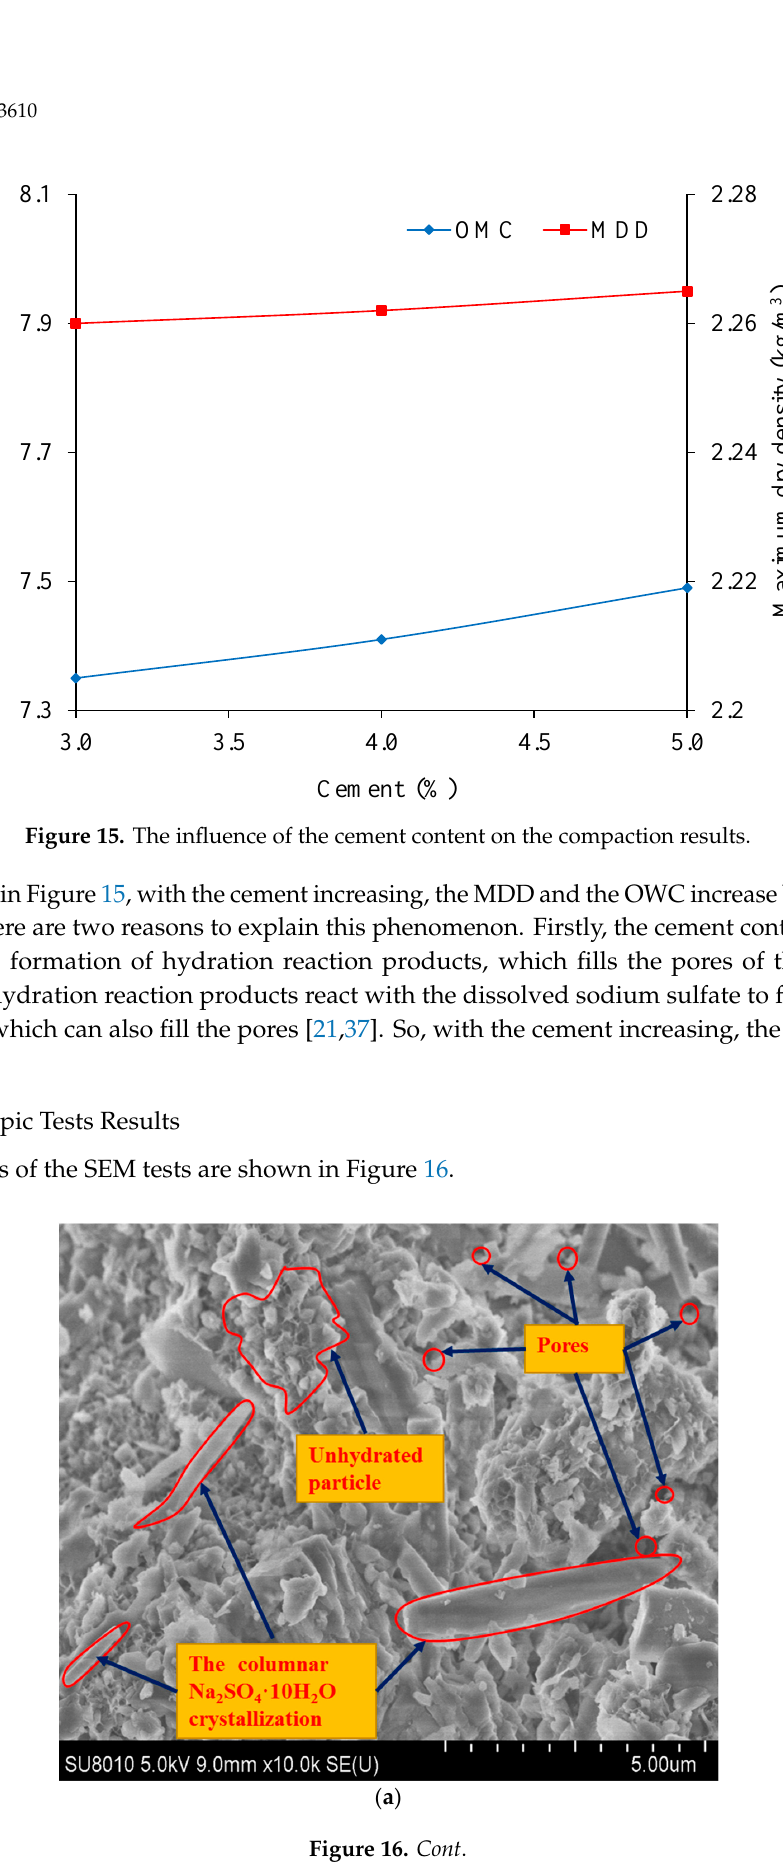
Figure 14. The relationship curves between water content and dry density.